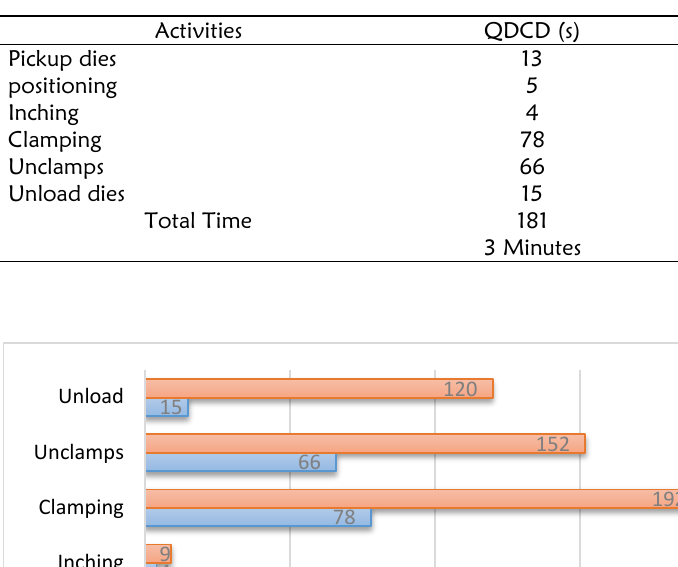
Table 1: Comparison of setup time